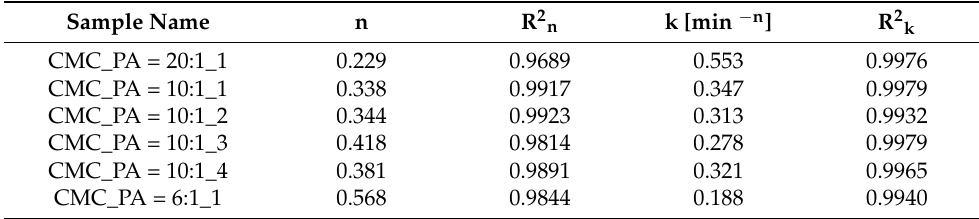
Table 3. Kinetic parameters of procaine release in PBS buffer medium of pH 7.4 at a constant temperature of 37 ◦